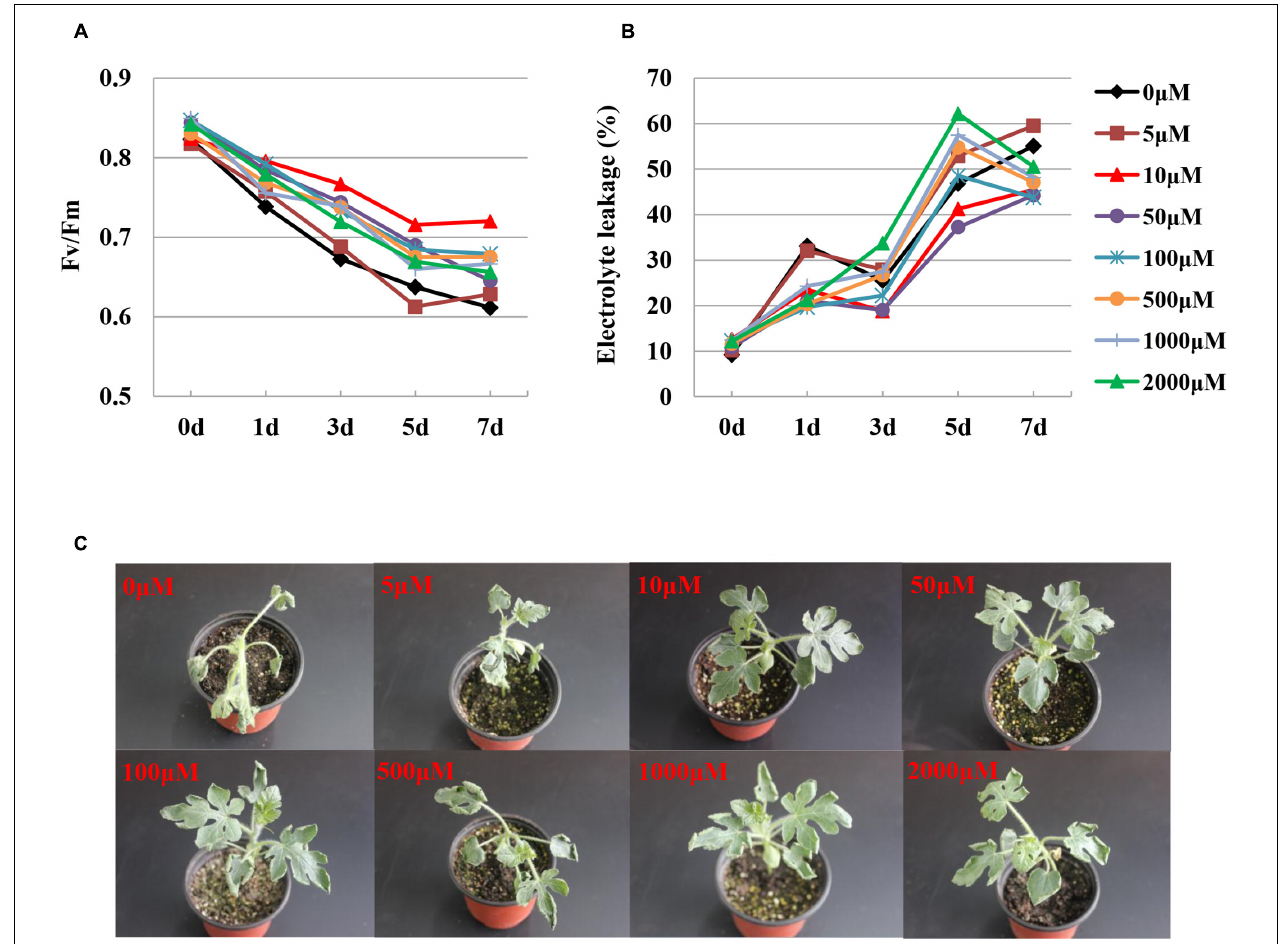
FIGURE 3 | Chilling tolerance phenotypes in different concentrations of SA-treated watermelon plants. (A) Average F v/ F m values in response to chilling stress. (B) Electrolyte leakage in response to chilling stress. (C) Phenotypes of SA-treated plants under chilling stress. F v/ F m and electrolyte leakage were measured at the indicated times after chilling treatment. The data are the means of four replicates. The picture of representative plants was taken after 7 days of chilling treatment.